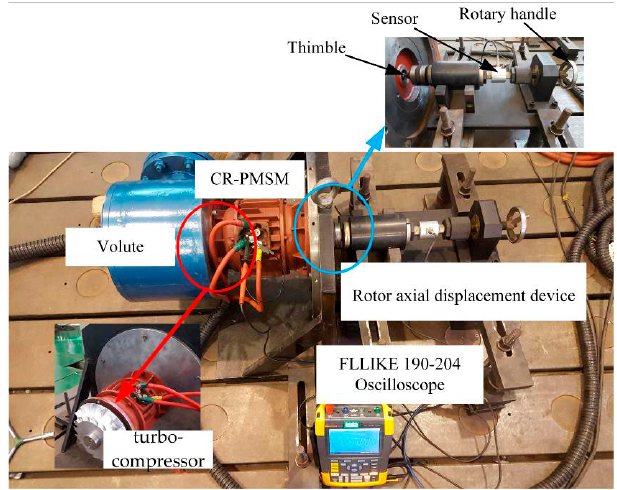
Figure 16. Experimental platform of CR-PMSM direct-driven turbo-compressor.